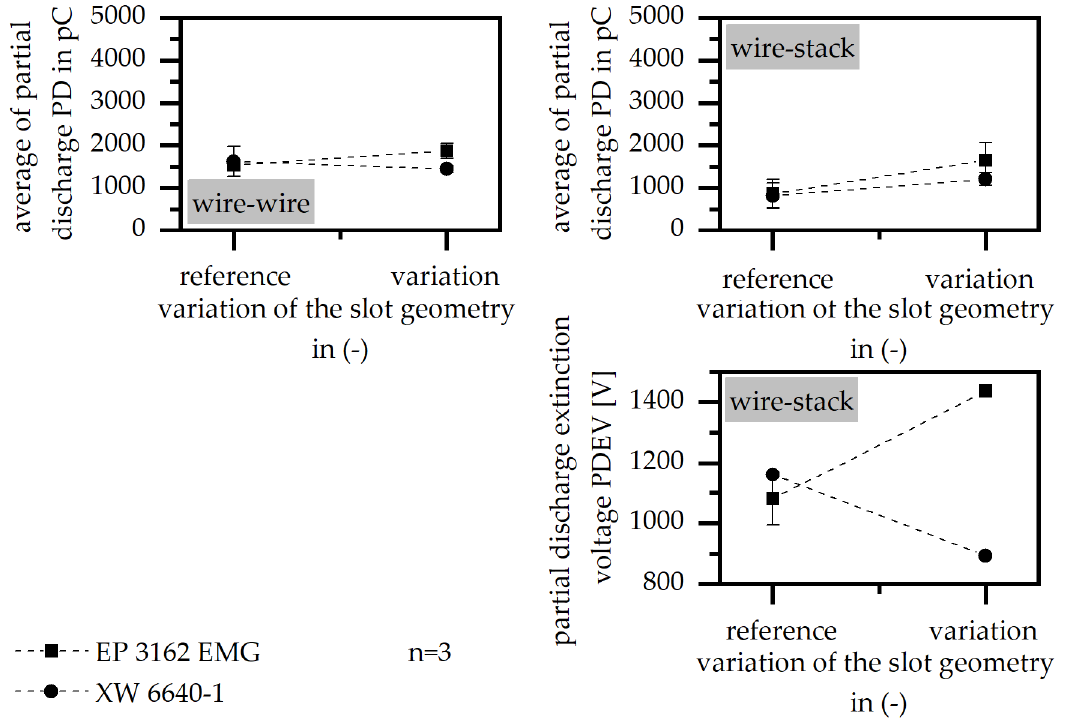
Figure 10. Average of partial discharge (PD) and partial discharge extinction voltage (PDEV), relative to the variation in the slot geometry and flow-improving grooves in the variation in the insulation system of wire to wire and wire to stack. Table 2. Improvement in PD and PDEV in the insulation system of the single slot sample by process conditions and slot